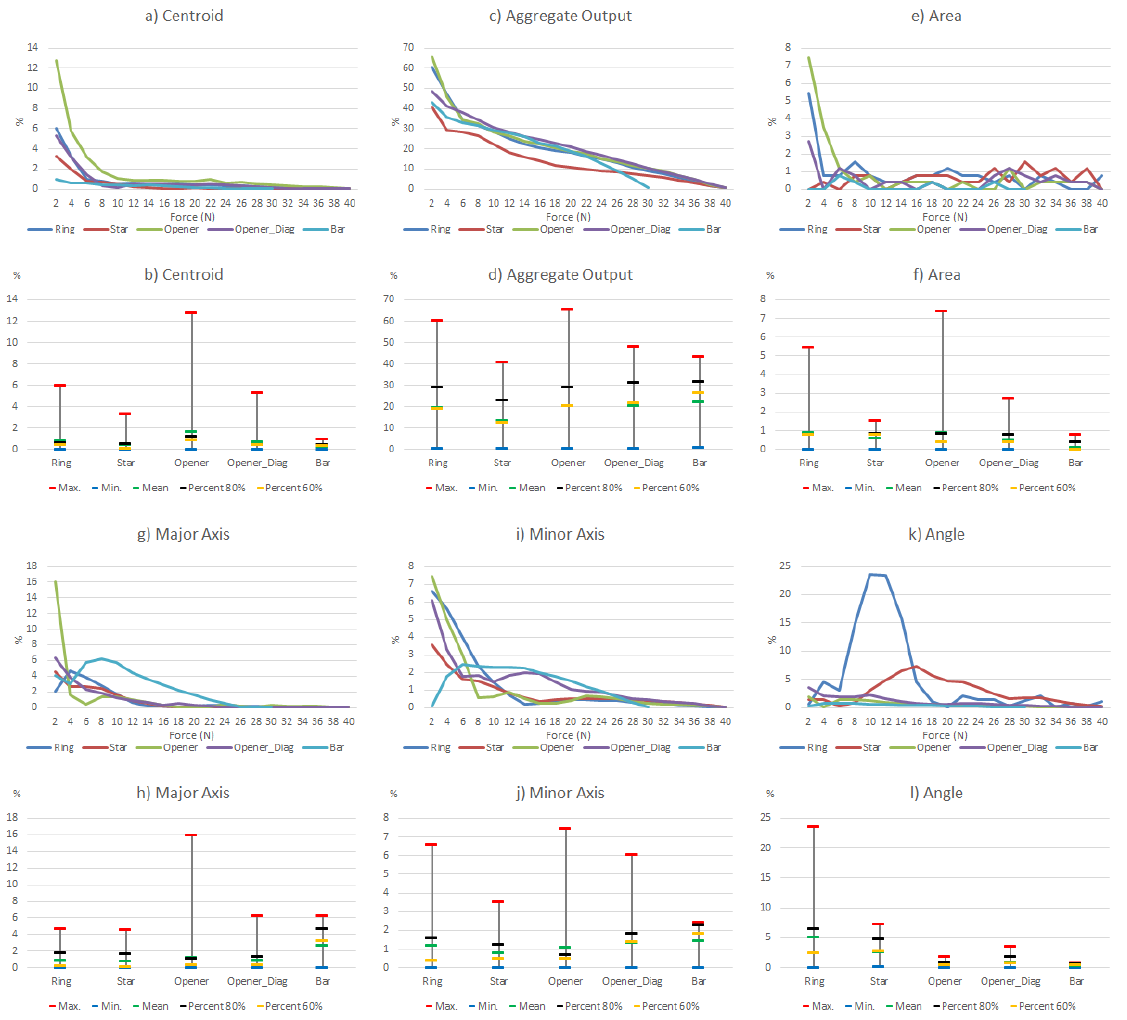
Figure 6. Variations of the system level parameters caused by the PCB based sensor